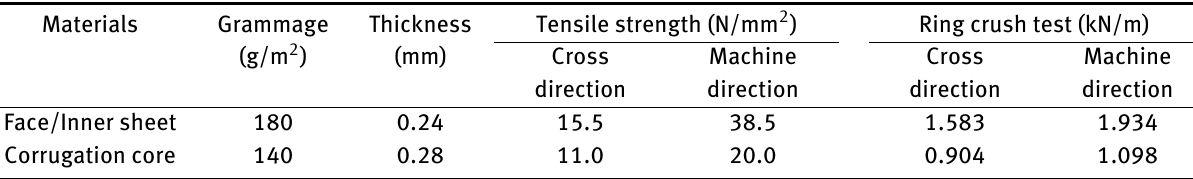
Table 1: Basic parameters of the BC-type corrugated paperboard Materials